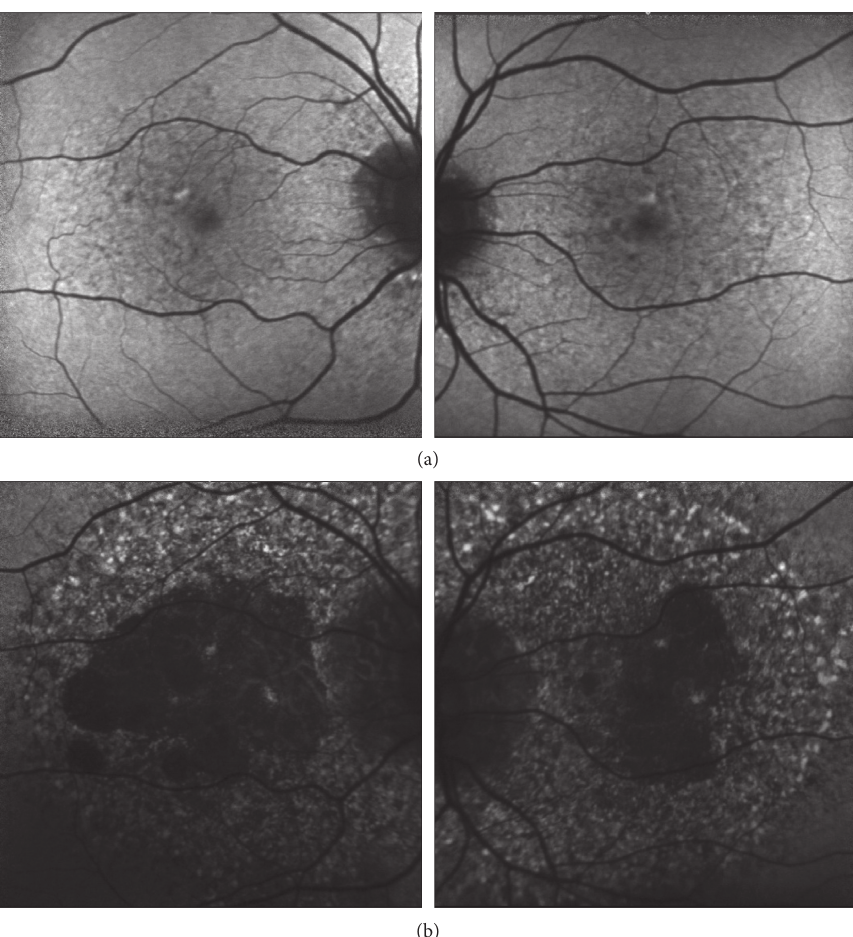
Figure 5: Progression of RPE macular atrophy. Images from patient 1 from July 2015 (20/40OU) demonstrate a mottled pattern of autofluorescence (a). By October 2019 (OD: CF, OS: 20/50), the images show late-stage changes consisting of numerous large lobules of hypoautofluorescence in both eyes of patient 1 (b). These lobules of absent autofluorescence correspond to the lobules of macular atrophy seen on examination and on color fundus imaging (Figure 2). There is a broader area of speckled hyper- and hypoautofluorescent ab- normality involving the entire